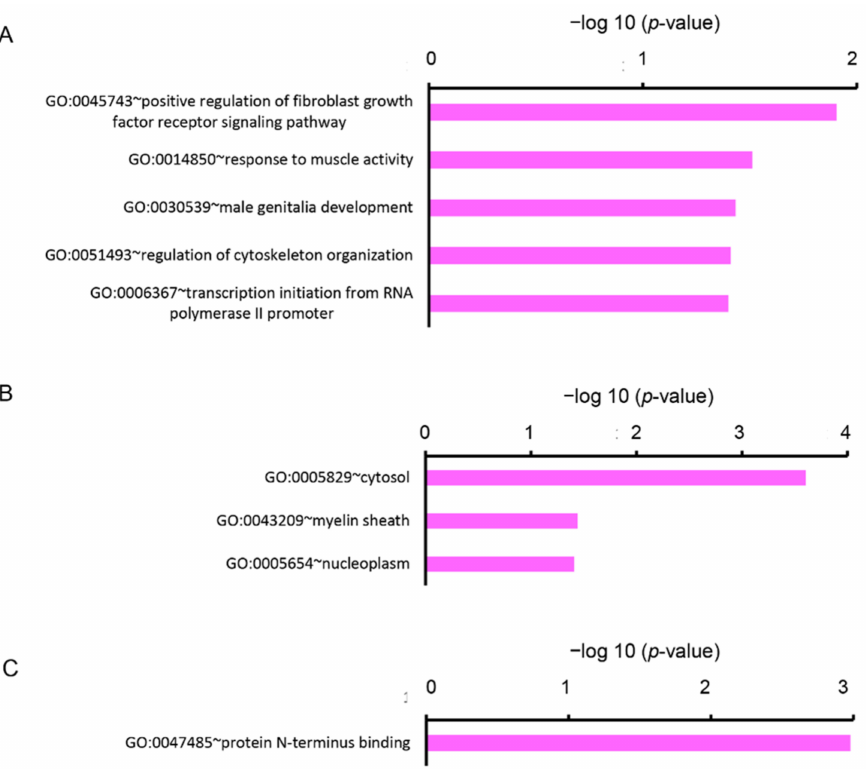
Figure 2. Functional analysis of upregulated DEGs between Cy3G-treated and untreated hAECs on day 7 represented ( A ) significantly enriched biological process, ( B ) cellular components, and ( C ) molecular functions analyzed by the Database for Annotation, Visualization, and Integrated Discovery (DAVID). The horizontal axis corresponds to − log10 p